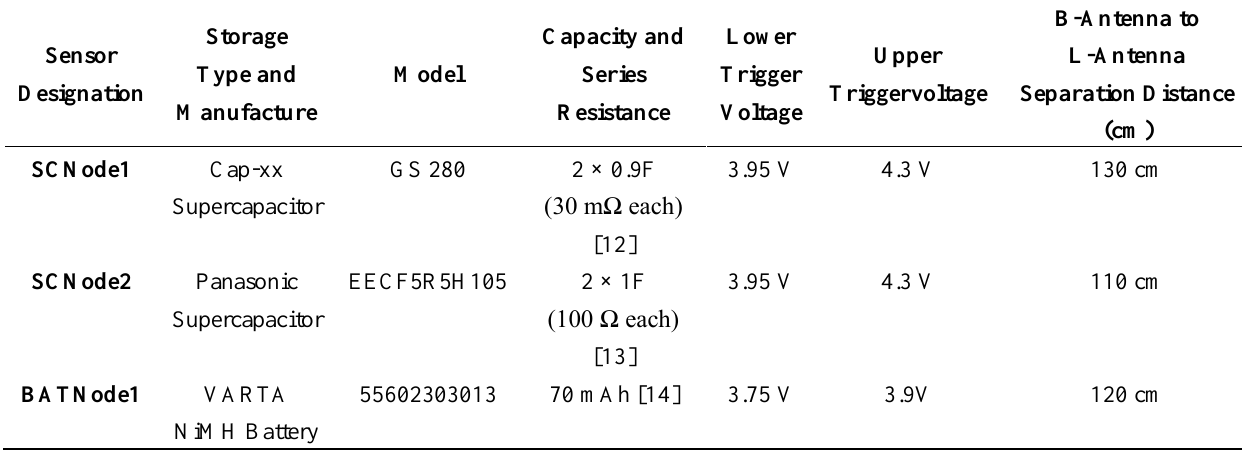
Table 1. Leaf node configurations including storage types and voltage thresholds.